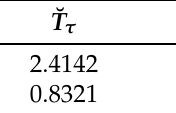
Figure 7. Instantaneous error states for the J part between for the variable ˘ x of (18) and ˘ y of (19) under 30 random initial values for fixed-time synchronization. Table 4. The related values under two